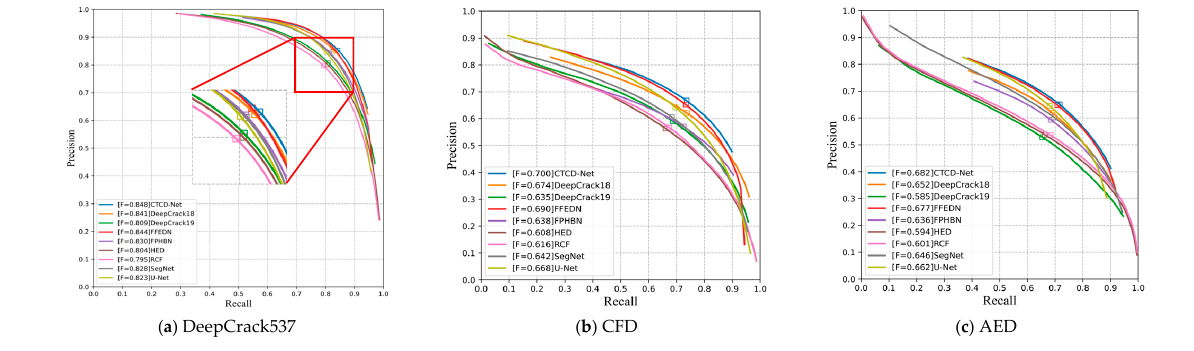
Figure 8. The PR curves on three datasets. Table 1. Comparison results on DeepCrack537.